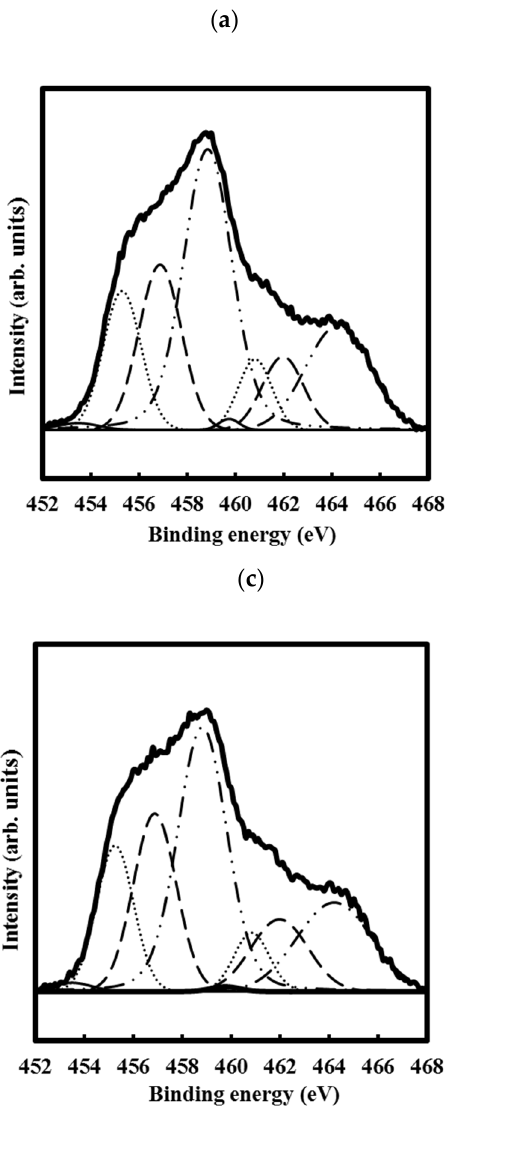
Figure 5. Deconvoluted Ti 2p peaks in XPS profiles of the Titania thin films: ( a ) FTOESD; ( b ) FTOSPIN; ( c ) QCNTESD; ( d ) QSPIN. The thick line ( – ) indicates the original XPS band corresponding to the binding energy range of Ti 2p electrons, while the lines, (—), ( ... ), (——), and (— ·· —) indicate the theoretically fitted curves assuming the Voigt distribution for Ti 0 , Ti 2 + , Ti 3 + , and Ti 4 + species,